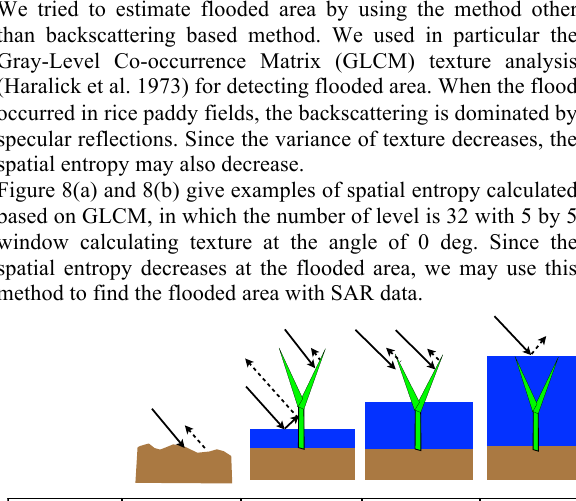
Table 2. Result of linear discriminant analysis for determining gamma-naught thresholds.